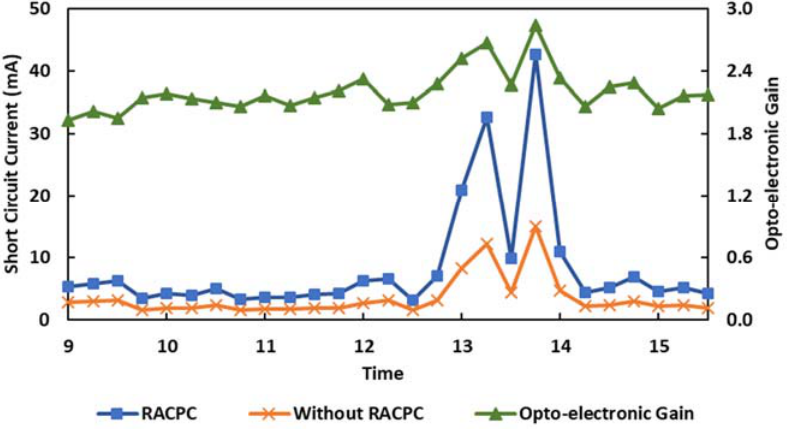
Figure 8. Results from outdoor experiments during an overcast day.